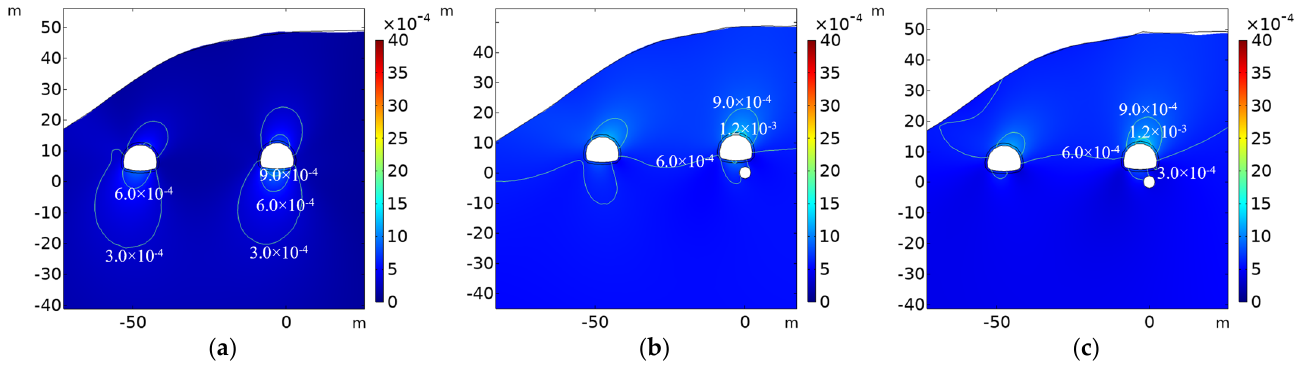
Figure 17. Tunnel and surrounding rock displacement distribution at 50 m of tunnel exit (unit: m): ( a ) comparison condition; ( b ) before treatment; ( c ) after treatment.